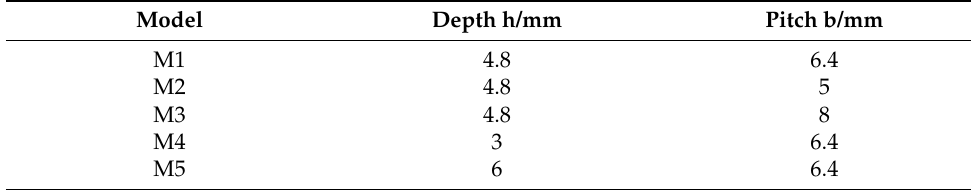
Table 1. Labyrinth seal model parameters Table 1. labyrinth seal model parameters table. Table 1. labyrinth seal model parameters table.